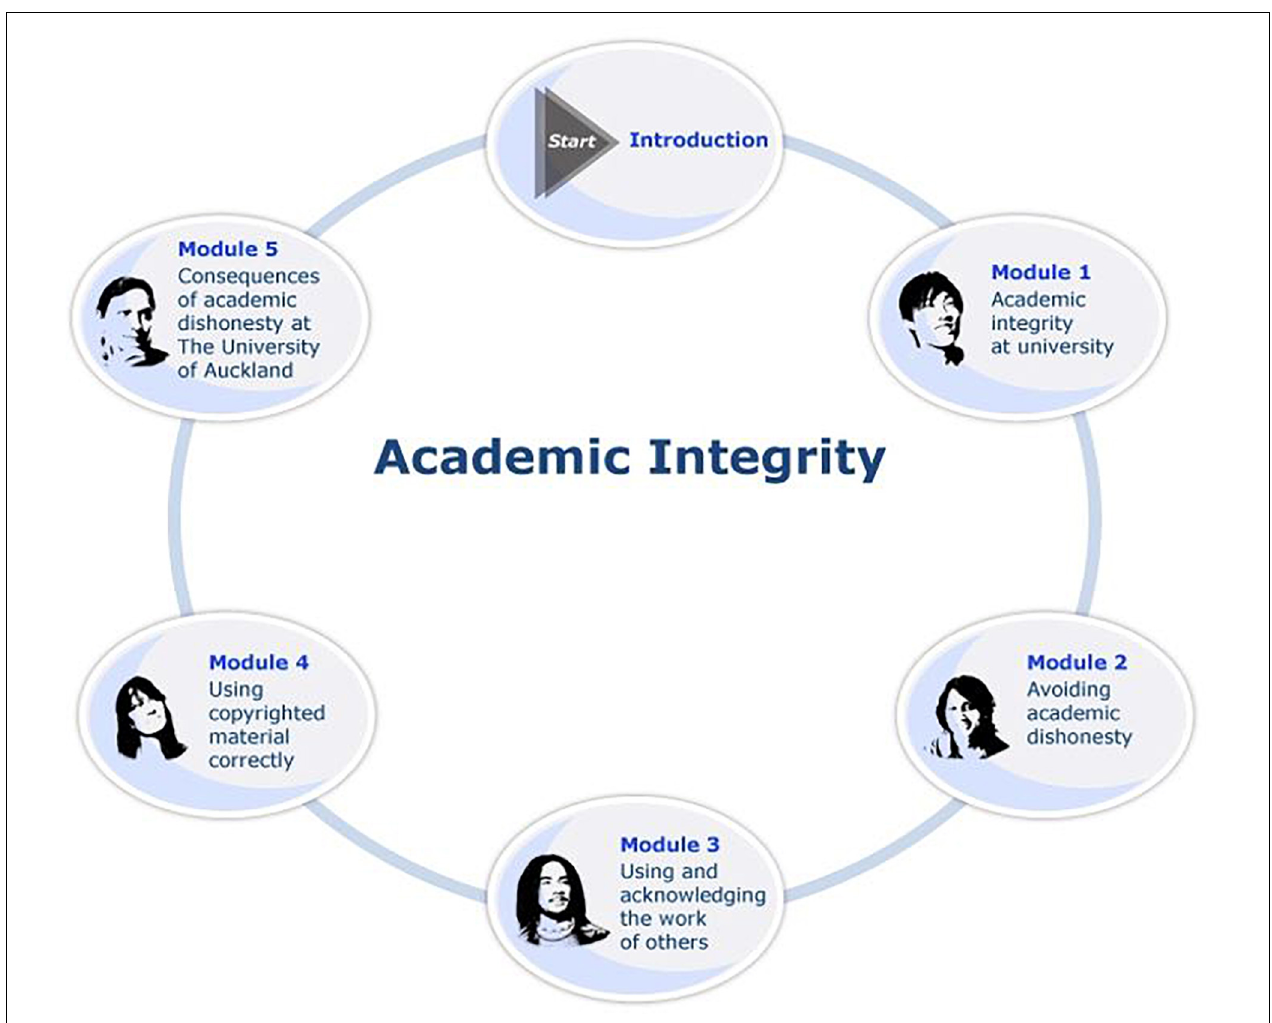
FIGURE 1 | The Academic Integrity Course (AIC) at the University of Auckland. The AIC is a self-paced online course in which students are automatically enrolled during their first semester at the